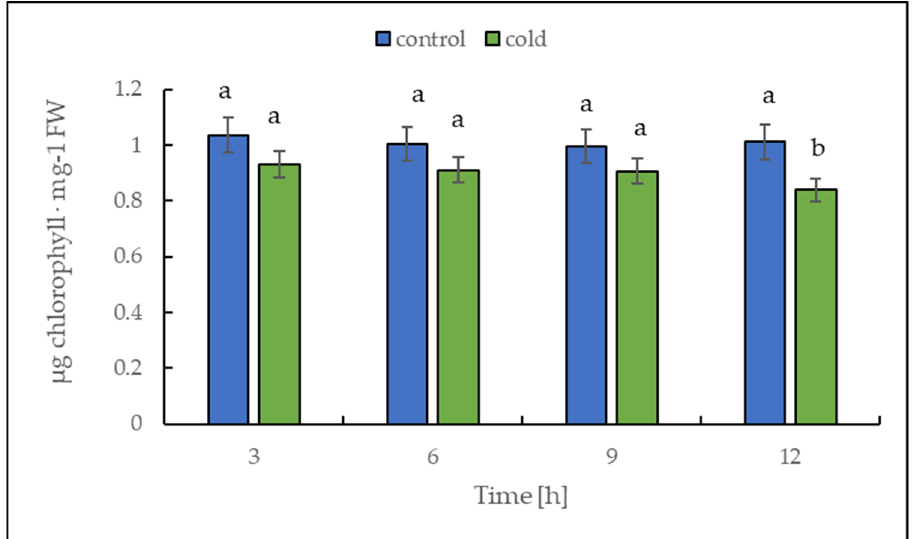
Figure 4. Chlorophyll content calculated on the basis of fresh weight (FW) in potato leaves growing under optimum conditions and exposed to low temperature. The results are the means of at least three biological replicates ± SD. Different letters at the top of the bars indicate significant differences, which were calculated ( p ≤ 0.05) according to Tukey’s HD post hoc test.